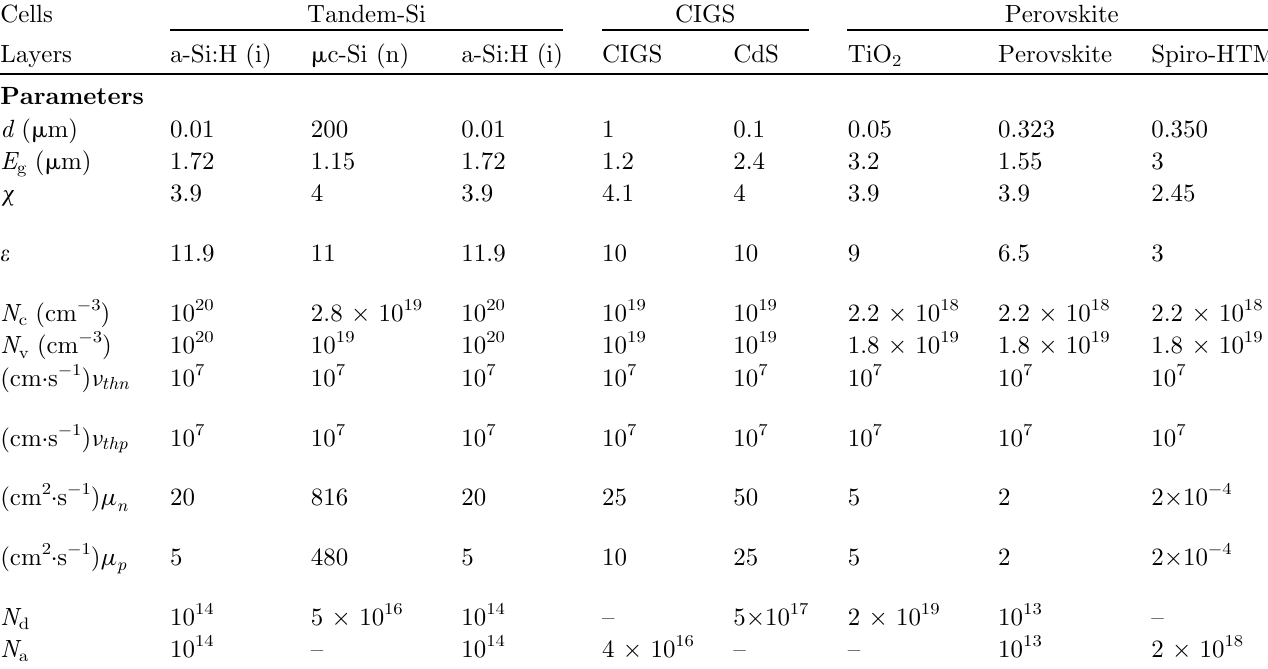
Table 1. Parameters of the layers forming the heterojunction for each cell.